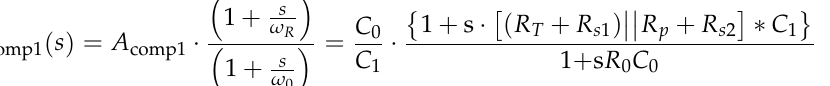
Figure 9. ( a ) The structure of compensation circuit for pole frequencies. ( b ) The structure of com- pensation circuit for sensitivity coefficient. ( c ) The image of the circuit board and thermistors.